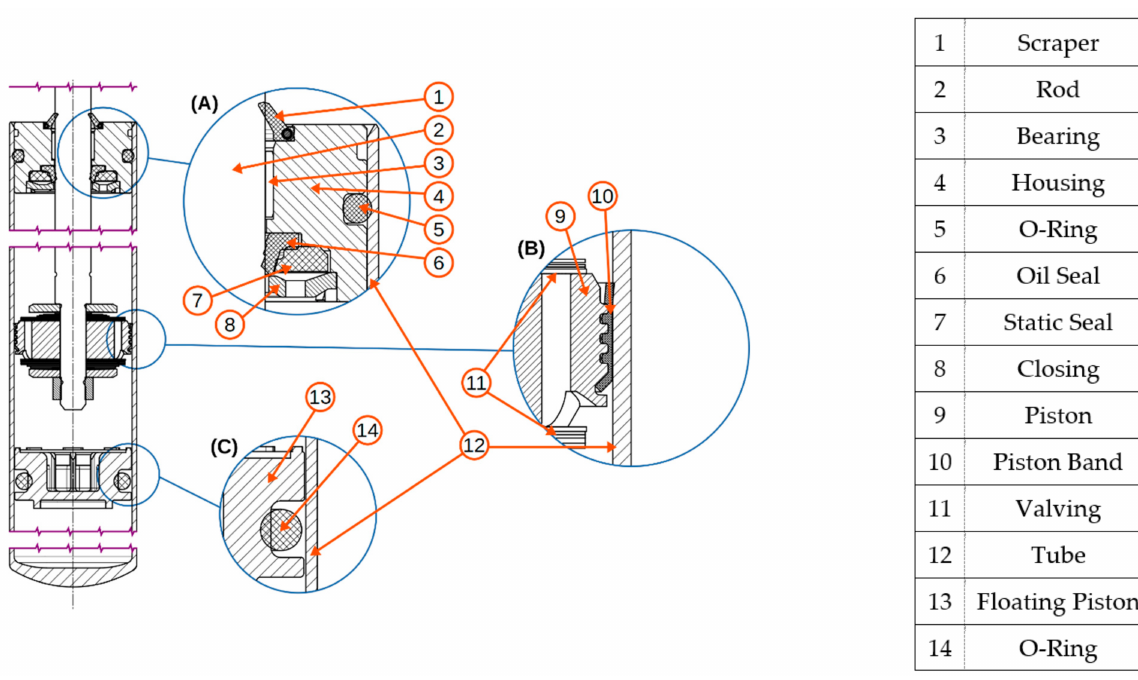
Figure 1. Reference damper overview with details of the single friction points. ( A ) Rod guide assembly/rod; ( B ) piston/tube; ( C ) floating